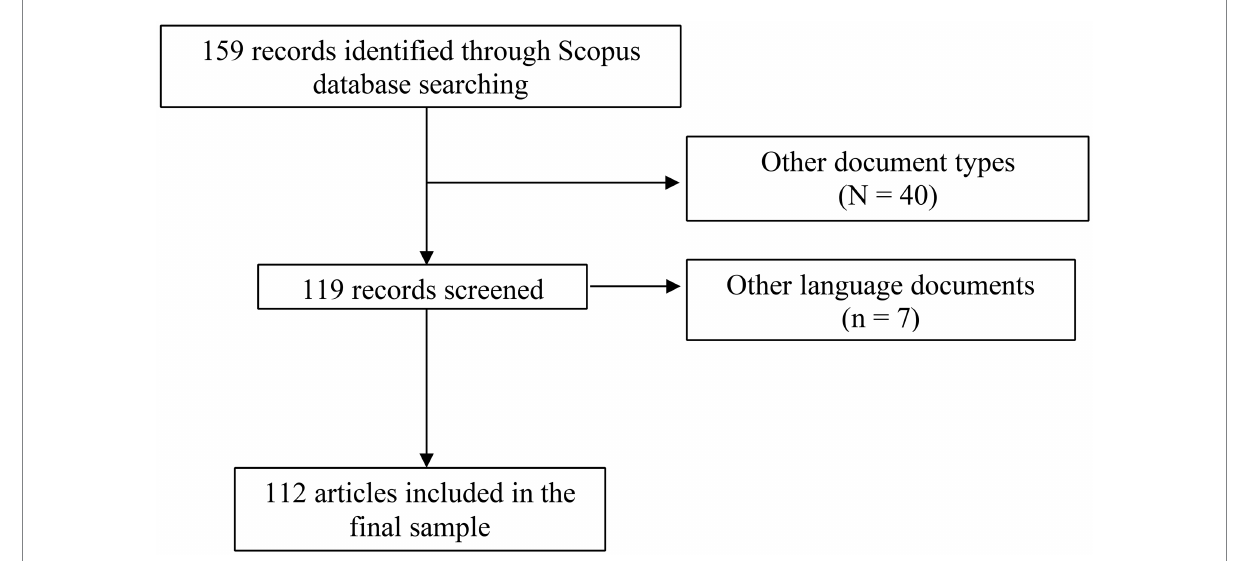
FIGURE 2 PRISMA diagram of included articles in the